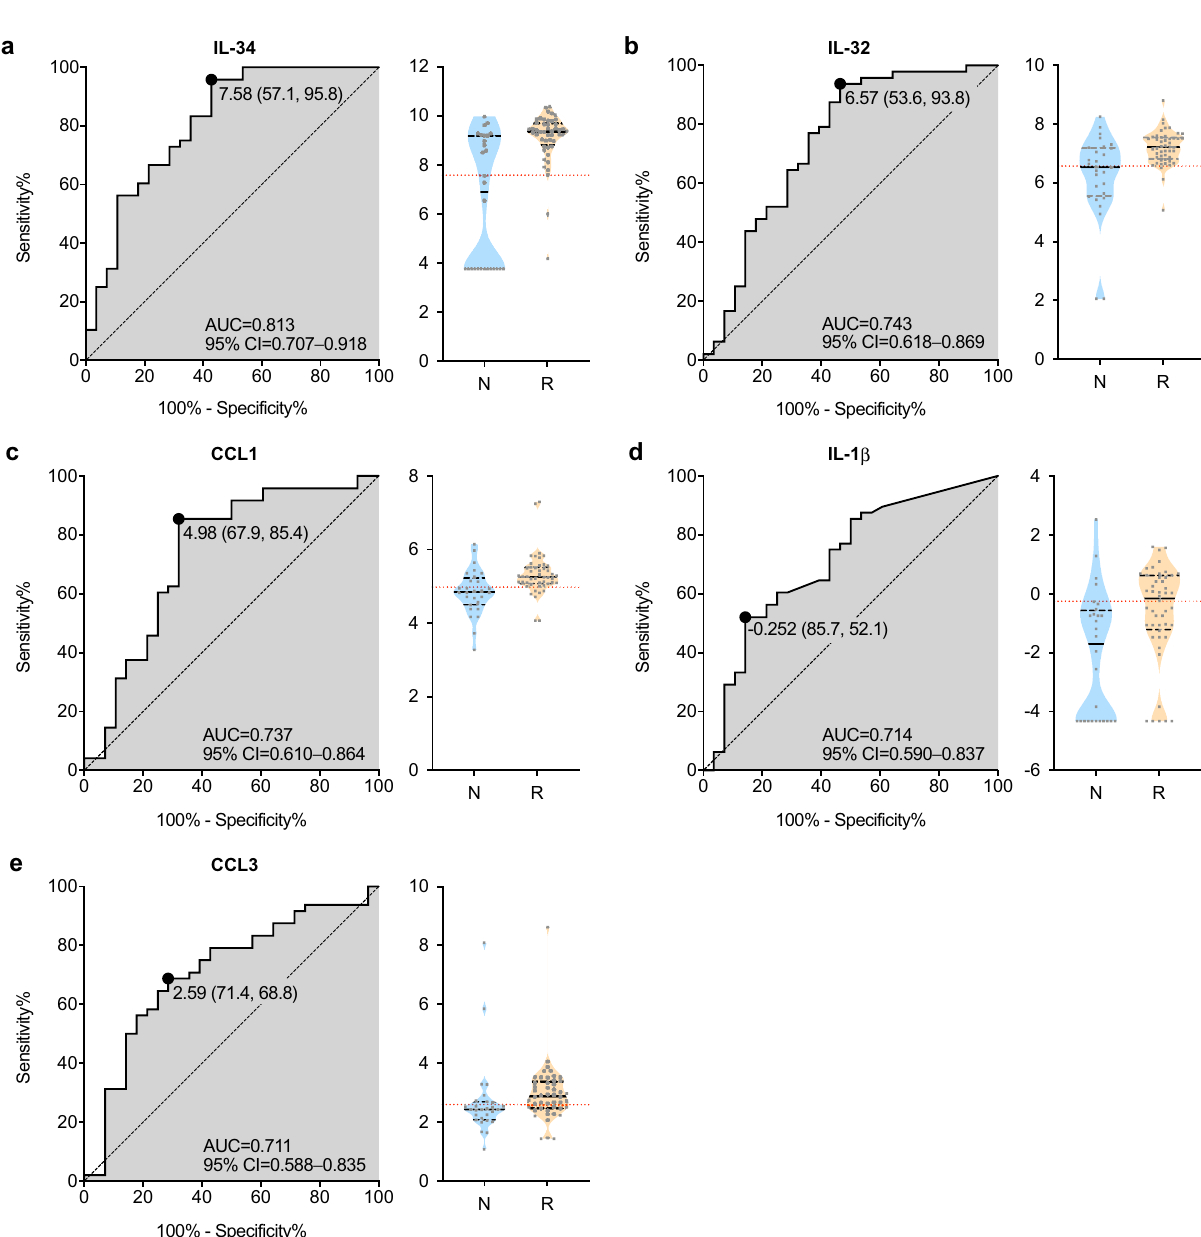
Figure 6. ROC curves and violin plots of the selected biomarkers. Serum levels of IL-34 ( a ), IL-32 ( b ), CCL1 ( c ), IL-1β ( d ), and CCL3 ( e ) are higher in the relapsed group than in the non-relapsed group. ROC curves (left) and violin plots (right) show the distribution of the log 2 transformed levels of biomarkers in relapse (R, orange) and non-relapse (N, light blue) samples. The area under the curve (AUC) for each of the ROC curves is annotated with the 95% confidence interval (CI) by Wilson/Brown method. The best threshold measured using “farthest to diagonal line” method with sensitivity and specificity was also shown as a dot on ROC curve and as a red dotted line in the violin plot. The serum concentration of the analyte was measured in each patient at time points A and F in the sustained remission group and at time points B and C in the relapse group (Fig. 1). The images were created using GraphPad Prism 8 (http:// www. graph pad.